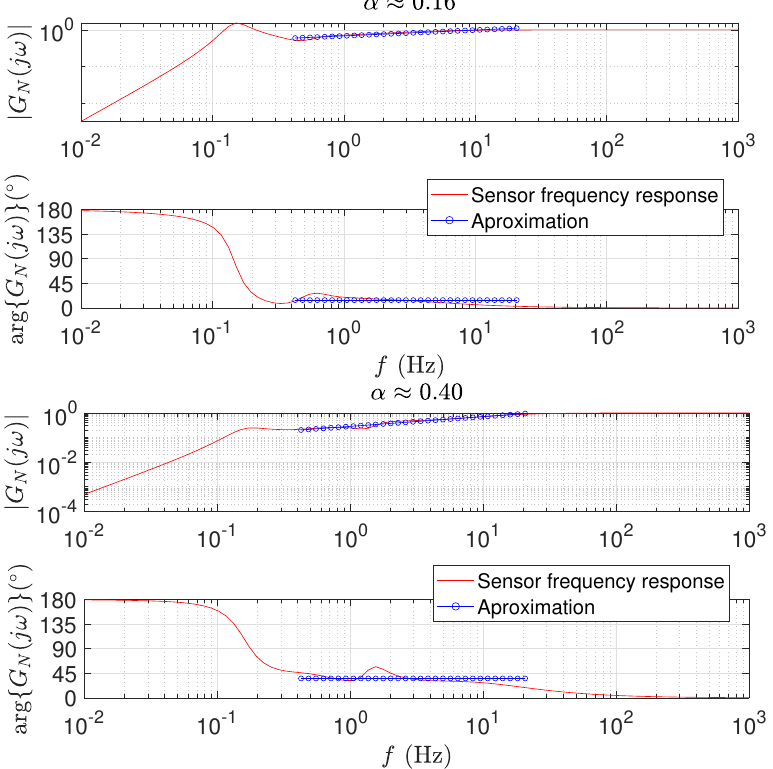
Figure 3. The Bode diagrams of a 6-stage fractional sensor, yielding the fractional orders: ( top ) α = 0.16; ( bottom ) α = 0.40. Table 1. Two optimal solutions determined by the PSO for N = 6, yielding the fractional orders α = { 0.16,0.40 } . Order Stage Elements